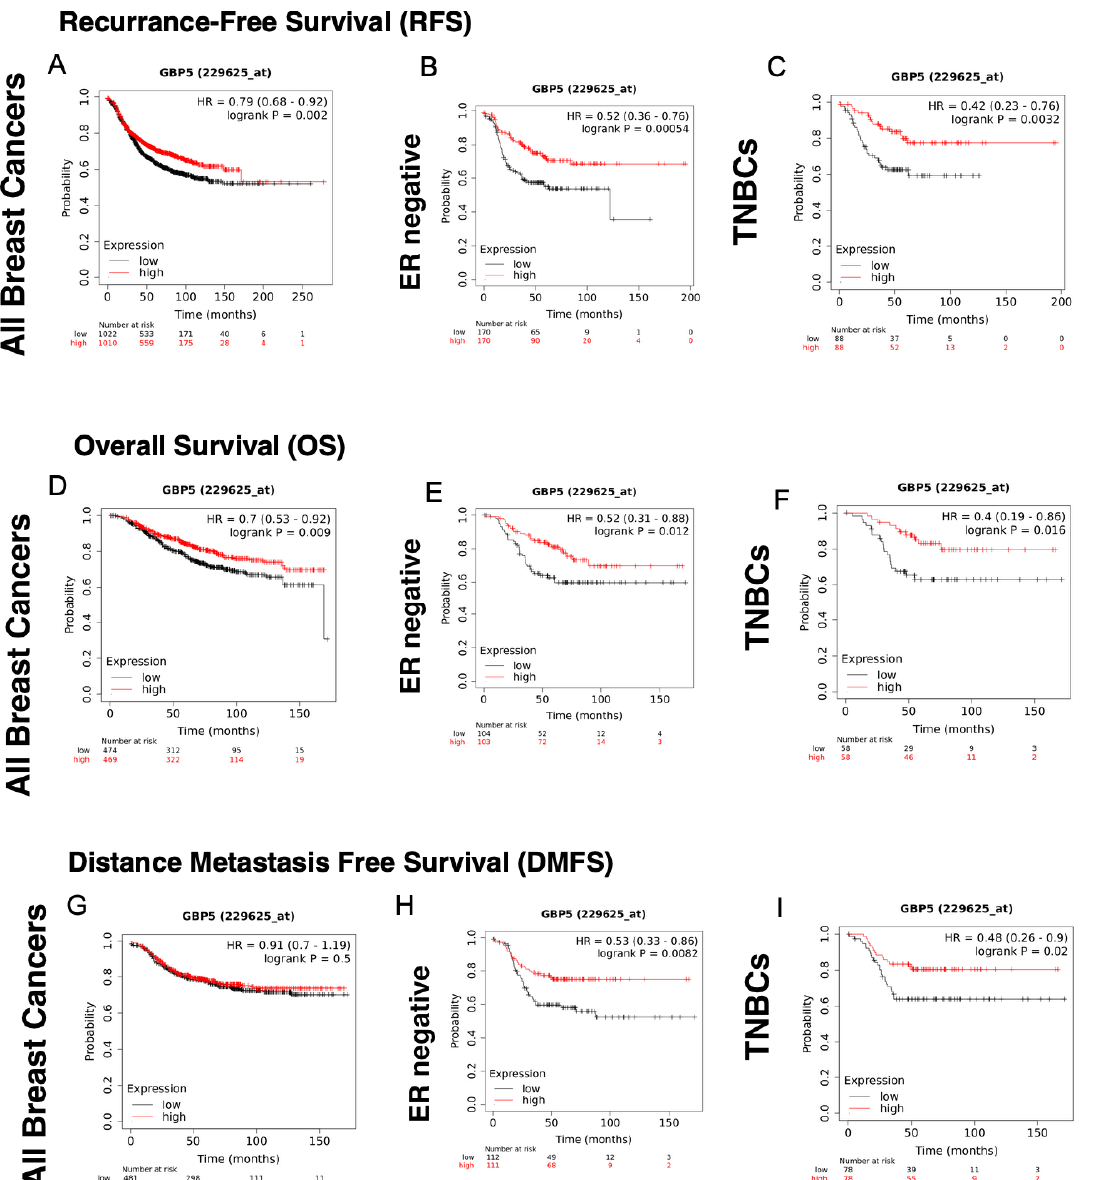
Figure 2. GBP-5 correlates with better recurrence-free (RFS) and overall survival (OS) in all breast cancers. The probability of RFS versus time for breast cancers of all types, stages, and grades was plotted for those tumors with high and low levels of GBP-5 expression ( A ). The probability of RFS versus time was plotted for ER − , PR − , and HER2 − (TNBC) breast cancers for high versus low levels of GBP-5 expression ( B , C ). The OS of patients of patients with all subtypes, stages, and grades was plotted for those tumors with high versus low GBP-5 expression versus time ( D ). The probability of OS versus time was plotted for ER − , PR − , and HER2 − (TNBC) breast cancers for high versus low levels of GBP-5 expression ( E , F ). The DMFS of patients of patients with all subtypes, stages, and grades was plotted for those tumors with high versus low GBP-5 expression versus time ( G ). The probability of DMFS versus time was plotted for ER − , PR − , and HER2 − (TNBC) breast cancers for high versus low levels of GBP-5 expression ( H , I